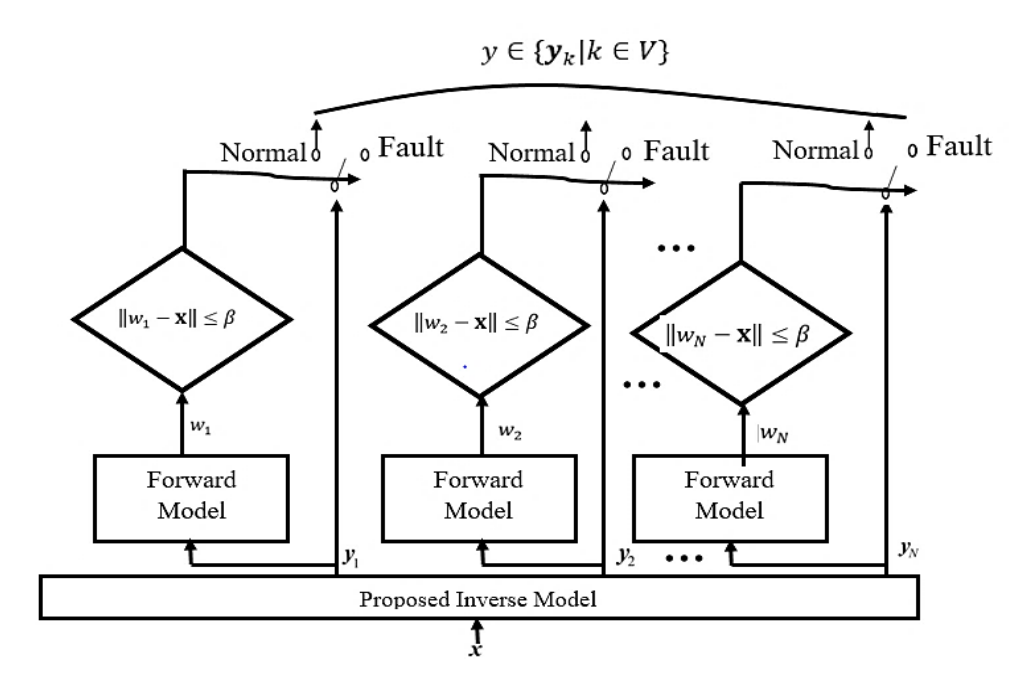
FIGURE 3. Fault detection technique of the proposed multivalued NN inverse